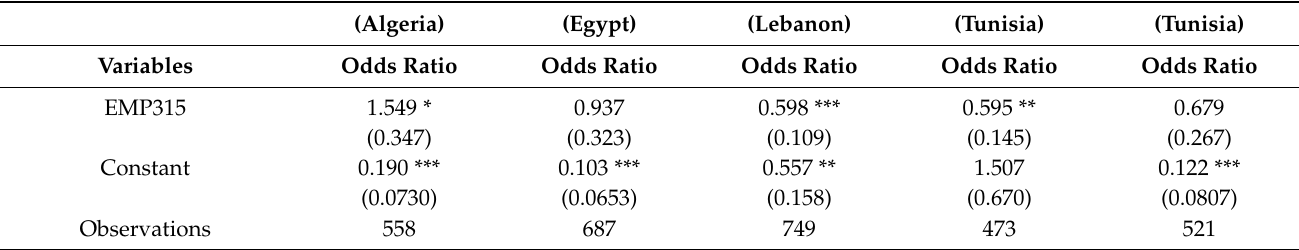
Table A8. Logistic regression on the “participation” index by country.